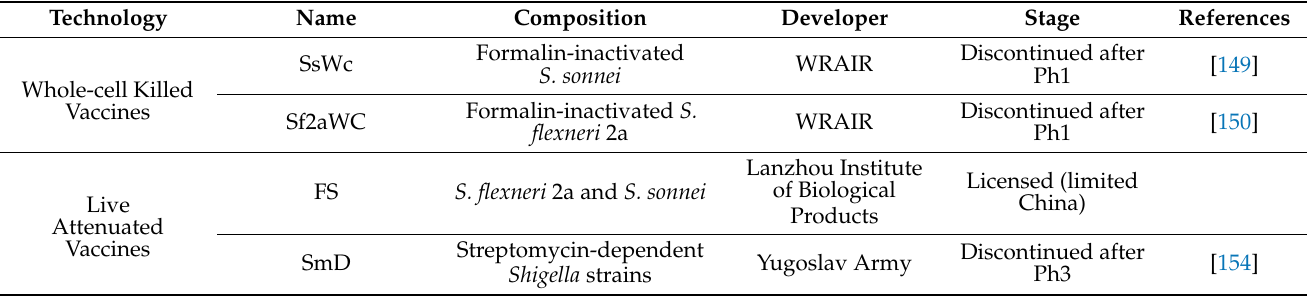
Table 1. Status of vaccine candidates in development against Shigella